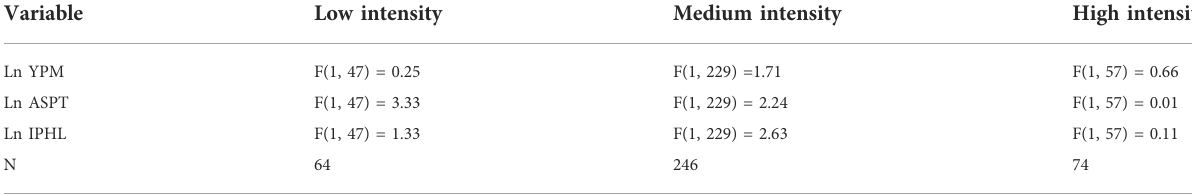
TABLE 2 Validity tests for the selection